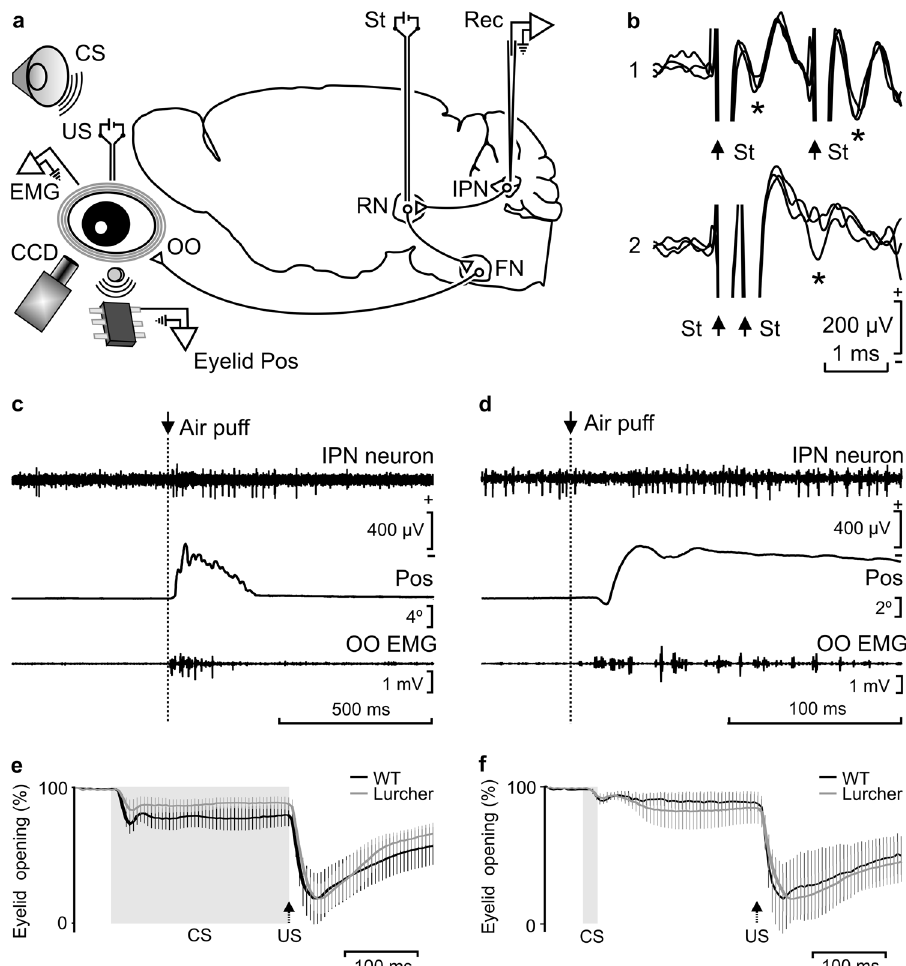
Figure 1. Experimental design and identification of recorded IPN neurons. ( a ) Diagrammatic representation of the experimental design. Mice were chronically implanted with stimulating electrodes on the left supraorbital nerve for US presentations and with EMG recording electrodes in the left orbicularis oculi (OO) muscle. A loudspeaker was used for the presentation of a tone as CS. Eyelid position (Eyelid Pos) was determined as the voltage difference between a Hall-effect sensor located on the head-holding system and a magnetic piece fixed to the lower eyelid. In addition, eyelid opening was detected with a fast CCD camera. Ipsilateral IPN neurons were recorded (Rec) with glass micropipettes and identified by their antidromic stimulation (St.) from the contralateral red nucleus (RN). FN, facial nucleus. ( b ) Overlapped (n = 3) traces of the antidromic activation ( * ) of a representative IPN neuron from the RN (St.) at threshold-straddling intensities and at different (1, 1.6 ms; and 2, 0.4 ms) interstimulus intervals. Note in 2 that the antidromic activation is partially prevented. Arrows indicate stimulus artifacts. ( c , d ) Representative examples of the firing rate of type A ( c ) and B ( d ) IPN neurons following the presentation of an air puff aimed at the ipsilateral cornea. Eyelid position (Pos) and OO EMG are also illustrated. ( e , f ) Typical CRs of trained WT and Lurcher animals collected during delay ( e ) and trace ( f ) conditioning paradigms. Values are mean ± SEM of eyelid closing percentages (n = 6 animals) obtained by a MATLAB-based analysis of the photographs taken with a fast CCD camera. Gray bands and black arrows represent CS duration and US presentation respectively. Note the different patterns of eyelid closing for delay and trace conditioning paradigms, but not between WT and Lurcher